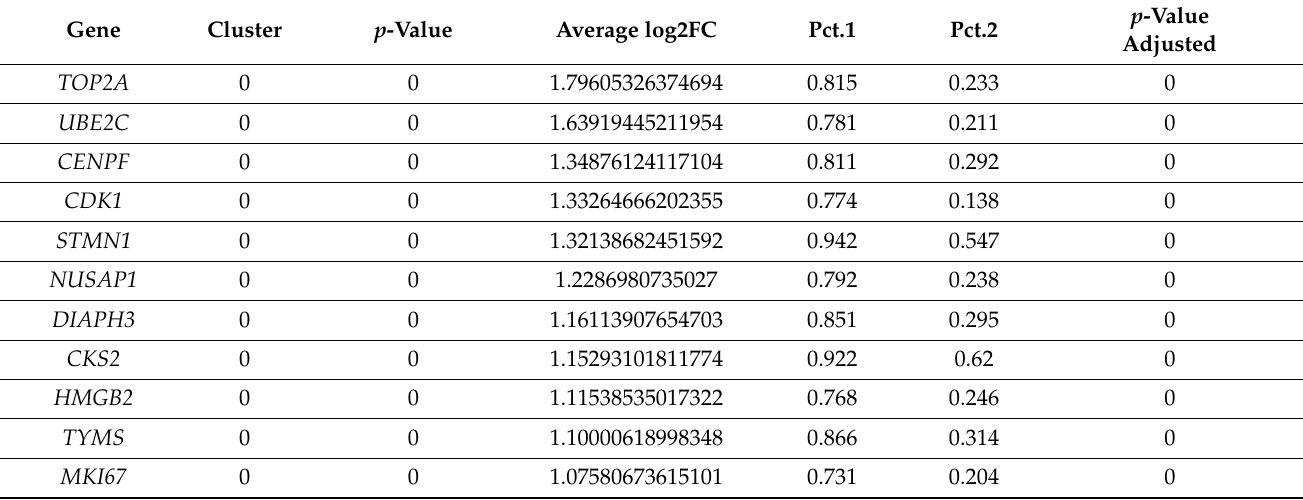
Table 3. Highly variable genes after cell cycle regression in CAFs isolated from